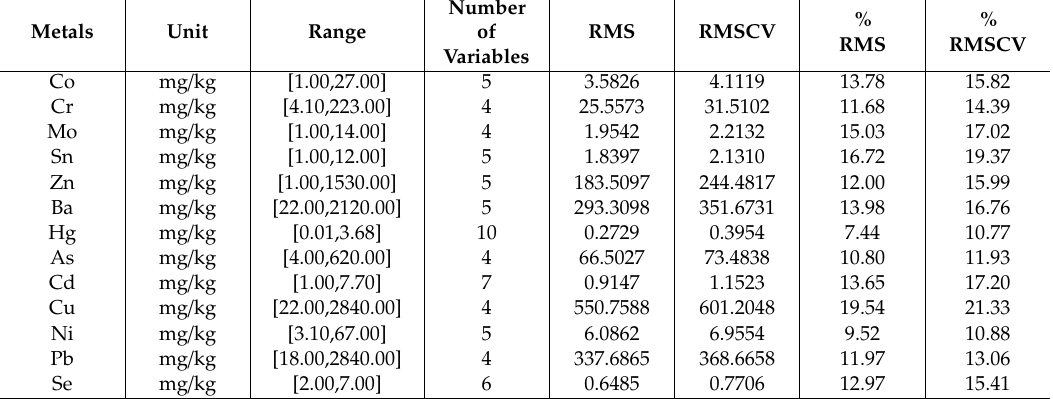
Table 1. The root mean square error (RMS) and root mean square error of cross validation (RMSCV) values for the PLS model based on ATR data in the FIR.